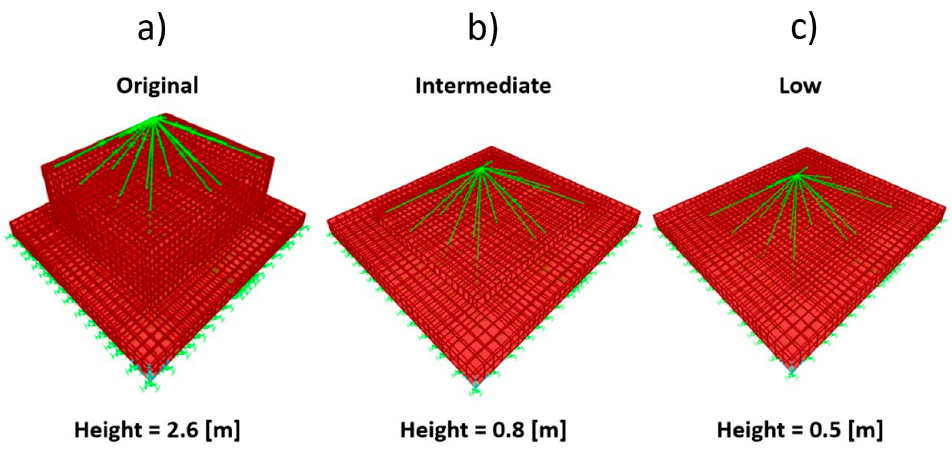
Figure 9. Schematization of the structure in the three configurations analyzed (a, b and c).